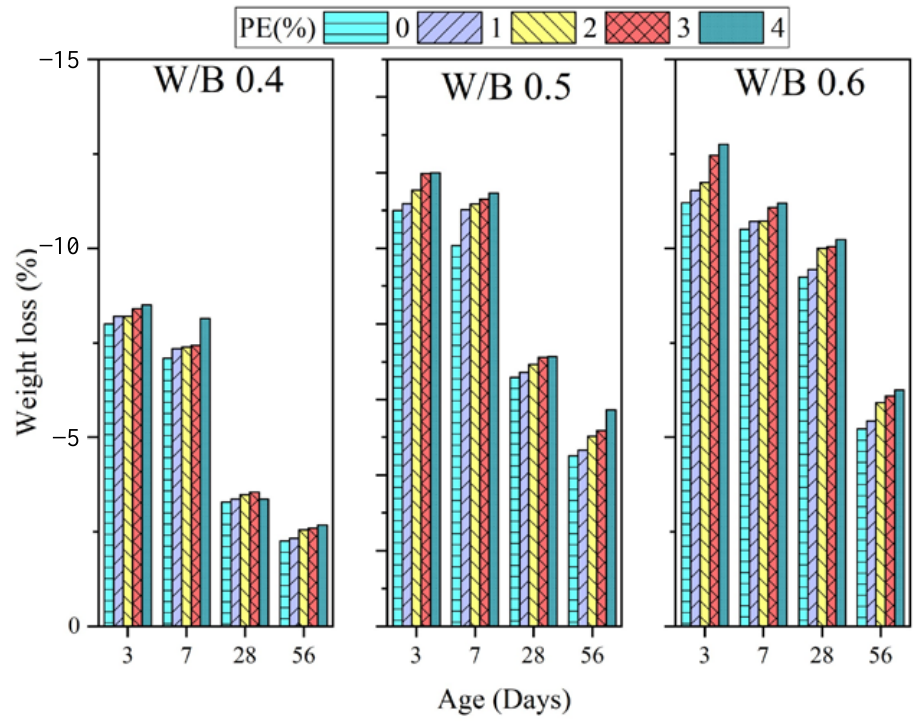
Figure 9. Water absorption rate of cement mortar with different W/B ratios and waste PE. percentages of waste PE added to the cement mortar, the water absorption rates are